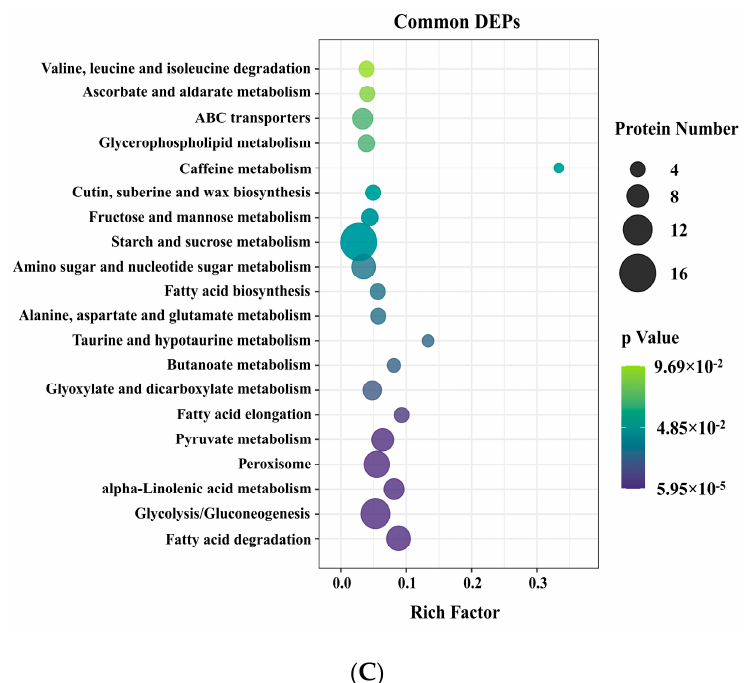
Figure 4. KEGG enrichment pathway analysis of differentially expressed proteins (DEPs) in grafted apricot hybrids. ( A ) DEPs enriched in KEGG pathways in peach/apricot (PA); ( B ) DEPs enriched in KEGG pathways in apricot/peach (AP); ( C ) common DEPs enriched in KEGG pathways in peach/apricot (PA) and apricot/peach (AP).